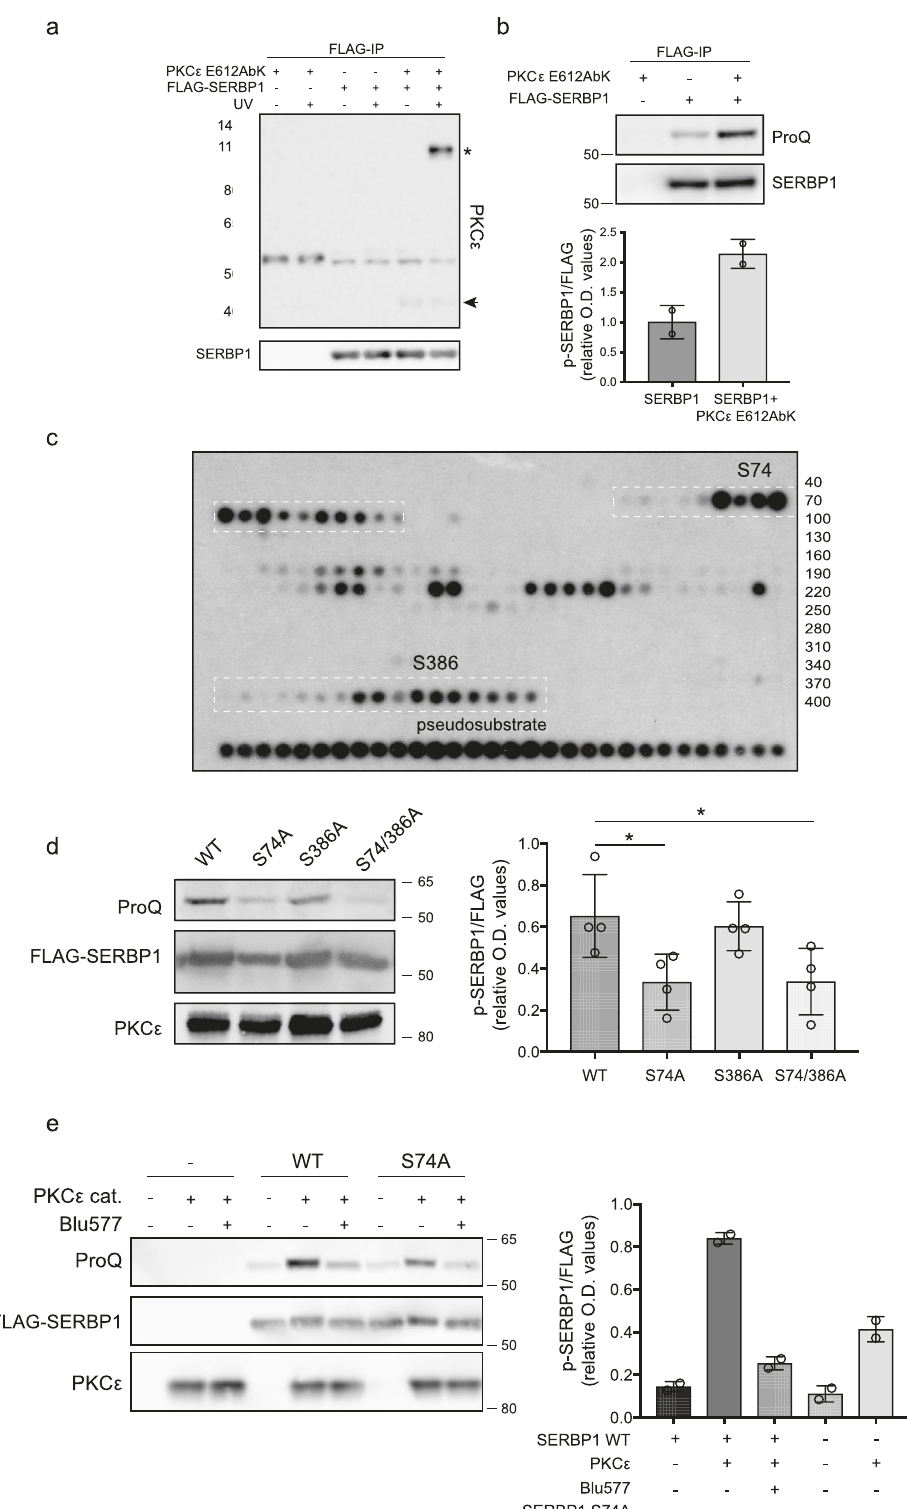
We further characterised M-body composition using a puri fi cation method previously described for isolation of SG cores from mammalian cells 24,25 . We validated the method (described in Supplementary Fig. 3d) by treating cells with arsenite and using immunoblotting to analyse the three fractions obtained: plasma membranes and cytoplasmic proteins (2 S), a